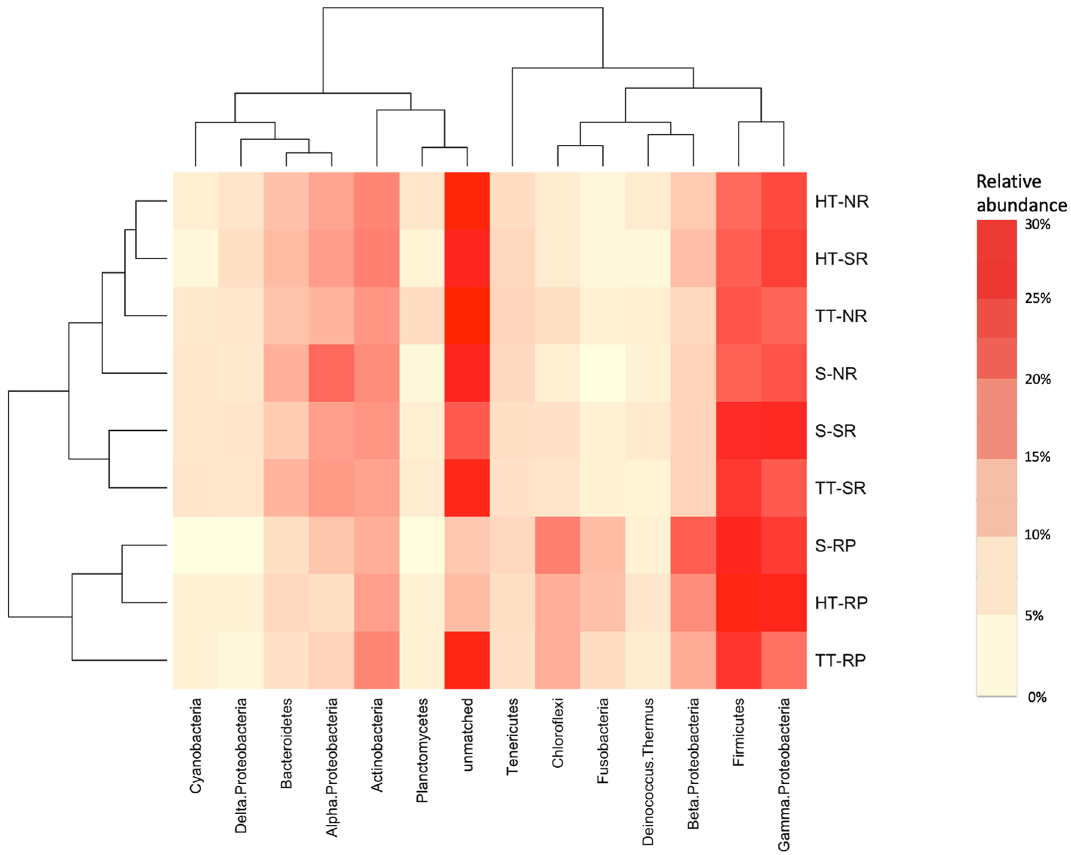
Figure 2. Relative abundance of main bacterial taxa detected by terminal restriction fragment length polymorphisms. Two-way clustering dendrogram obtained using Spearman distance with average grouping algorithm to evaluate the distribution of bacterial communities from the different sites and compartments at the phylum level. The heat map colors represent the relative abundance percentage (right hand legend) of the bacterial phylum (X-axis clustering) within each site/compartment (Y-axis clustering). HT-NR Huana tailings-non rhizosphere, HT-SR Huana tailings rhizosphere, TT-NR Tambillos tailings-non rhizophere, S-NR surrounding soil-non rhizosphere, S-SR surrounding soil rhizosphere, TT-SR Tambillos tailings rhizosphere, S-RP surrounding soil rhizoplane, HT-RP Huana tailings rhizoplane, TT-RP Tambillos tailings rhizoplane. This image was created using RStudio Team. Version 1.0.143. URL http:// www. rstud io.